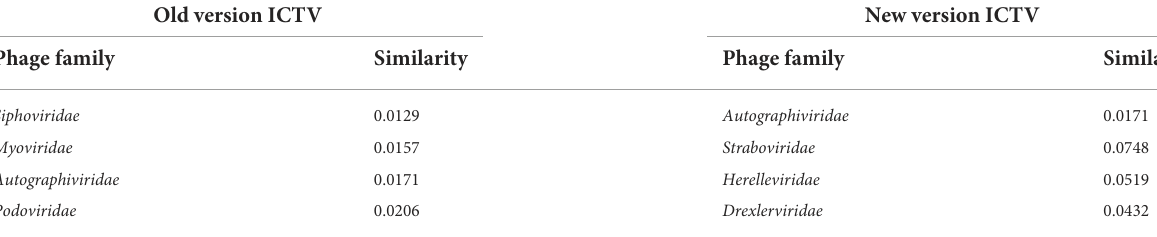
TABLE 1 The average pairwise Dashing similarity of the four largest phage families under Caudoviricetes